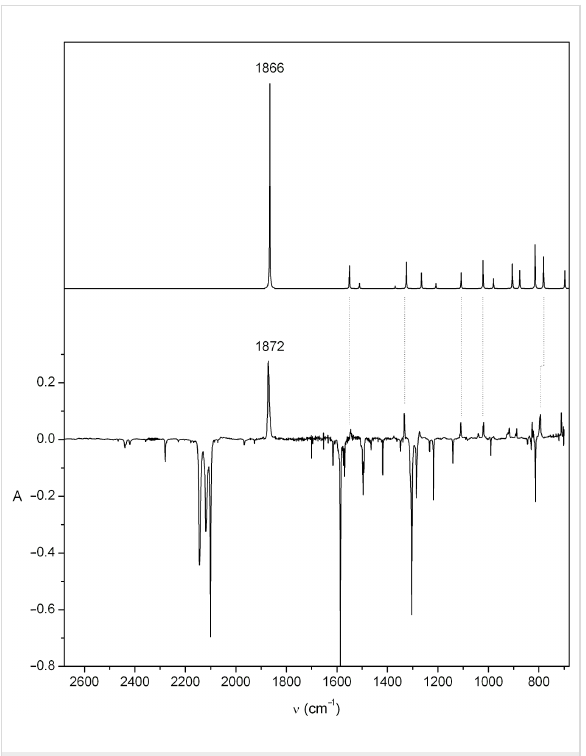
Figure 3: Top: calculated IR spectrum of 20 at the B3LYP/6-31G* level (wavenumbers scaled by 0.9613): ν ’ (relative intensity) 697 (9), 782 (16), 815 (22), 876 (9), 905 (12), 980 (5), 1021 (14), 1108 (8), 1208 (3), 1265 (8), 1325 (13), 1511 (3), 1550 (11), 1866 (100) cm − 1 . Ordinate in arbitrary absorbance units. Bottom: Ar matrix IR-difference spectrum of diazacycloheptatetraene 20 ( ν ’ 710, 794, 826, 887, 1028, 1109, 1272, 1332, 1545, 1872 cm − 1 ), formed by photolysis of 4-azidopyridine ( 18 ) (3 min broadband UV; positive bands due to 20 ; negative bands due to 18 ). See Figures S2 and S3 in Supporting Infor- mation File 1 for full spectra of 18 and 20 with peak listings.